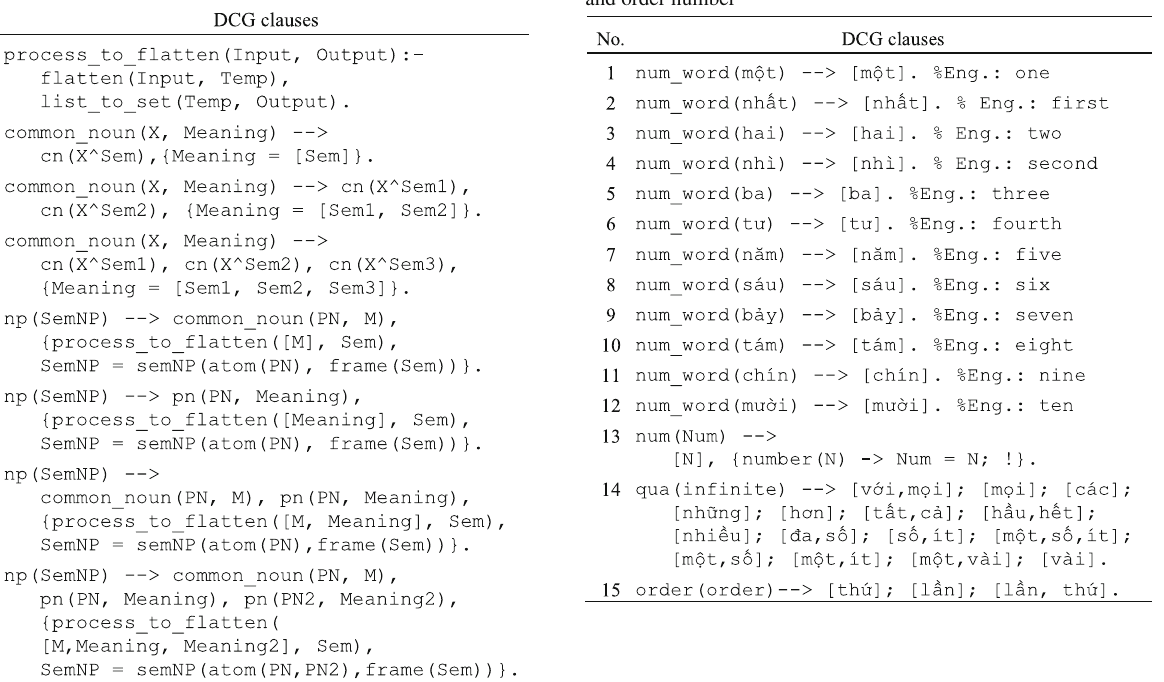
Table 2 DCG clauses for handling the semantics of noun